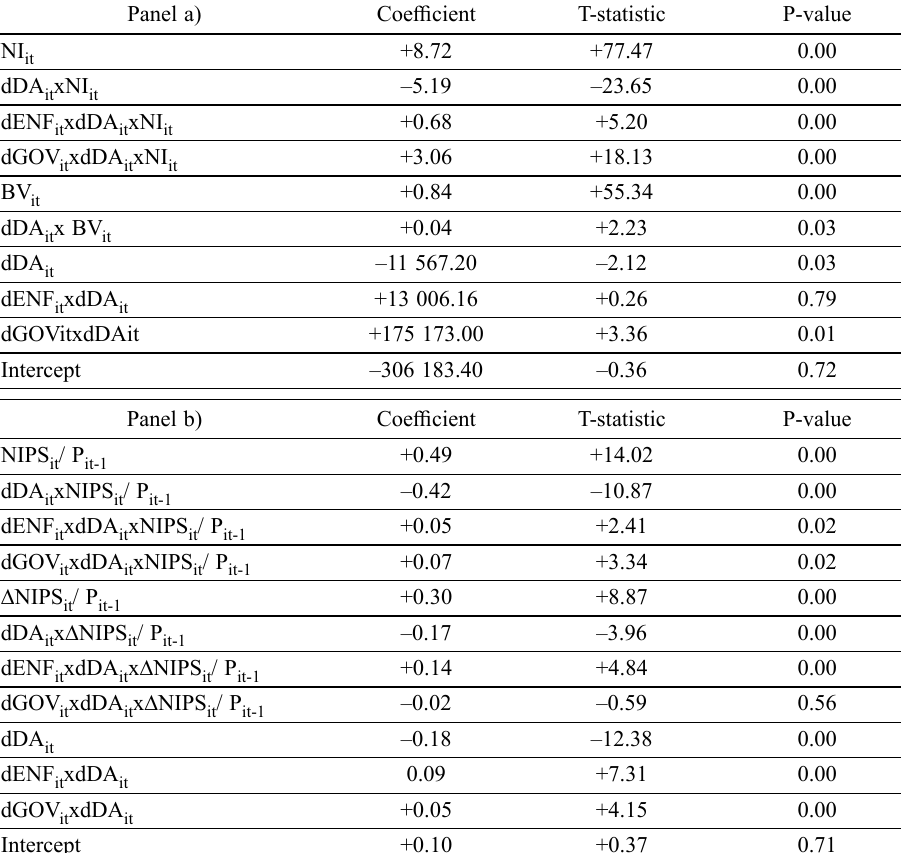
Table 2. Research